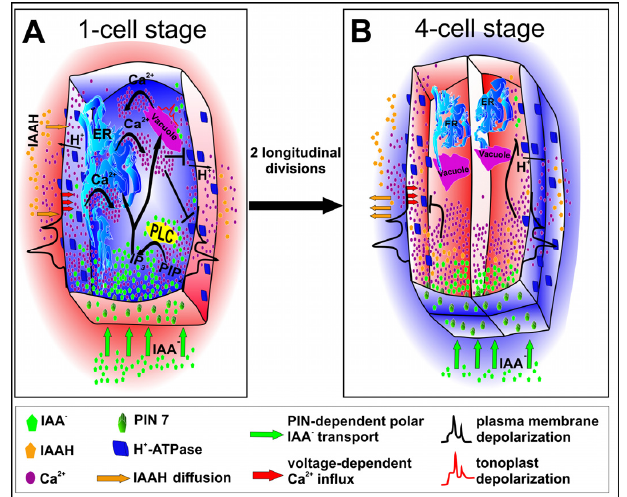
depolarization, followedbyanopeningofcalciumchannels.